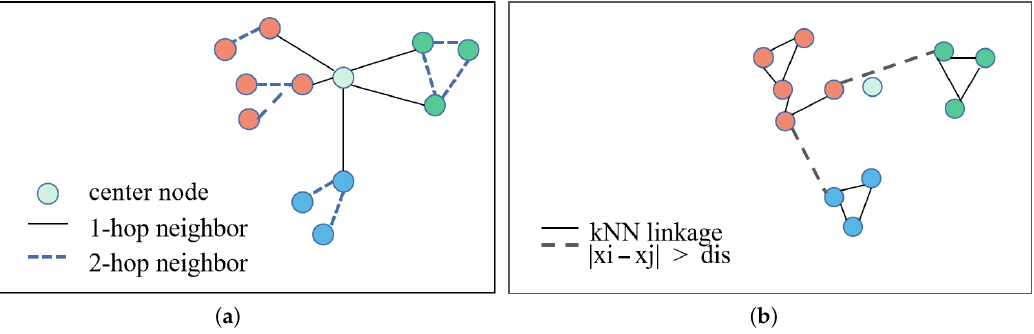
Figure 2. Construction of adaptive subgraph. ( a ) Finding nodes; ( b ) Adding